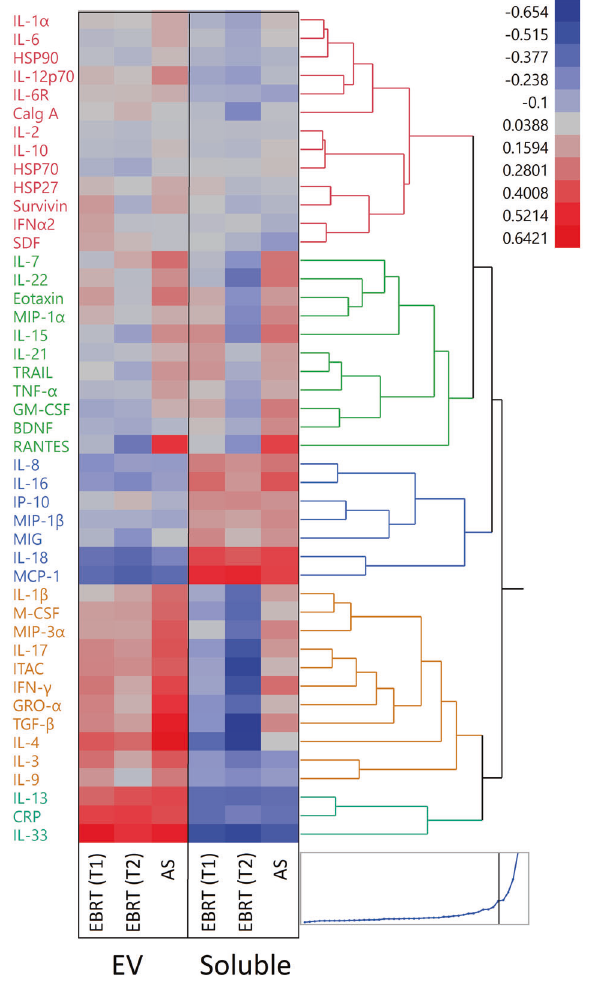
Fig. 3 Hierarchical cluster of average cytokines, chemokines, and heat-shock protein expression in logarithm base ten from multiplexed bead-based arrays. Clustering shows the relative differences in concentrations of the markers between EV and soluble fractions. The fi ve different color-coded dendrograms shows clusters of biomarkers with similar expression values across the EV and soluble fractions. EBRT external beam radiation therapy, T1 at the start of radiation, T2 3 months post radiation, AS active surveillance.